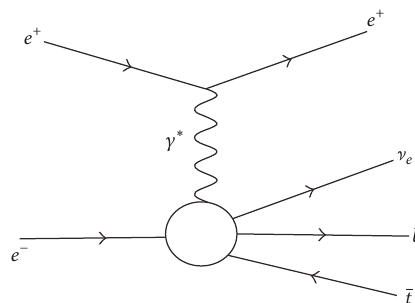
Figure 1: Schematic diagram for the process of single top quark production 𝑒 + 𝑒 − → 𝑒 + 𝛾 ∗ 𝑒 − → 𝑡𝑏 ] 𝑒 𝑒 +